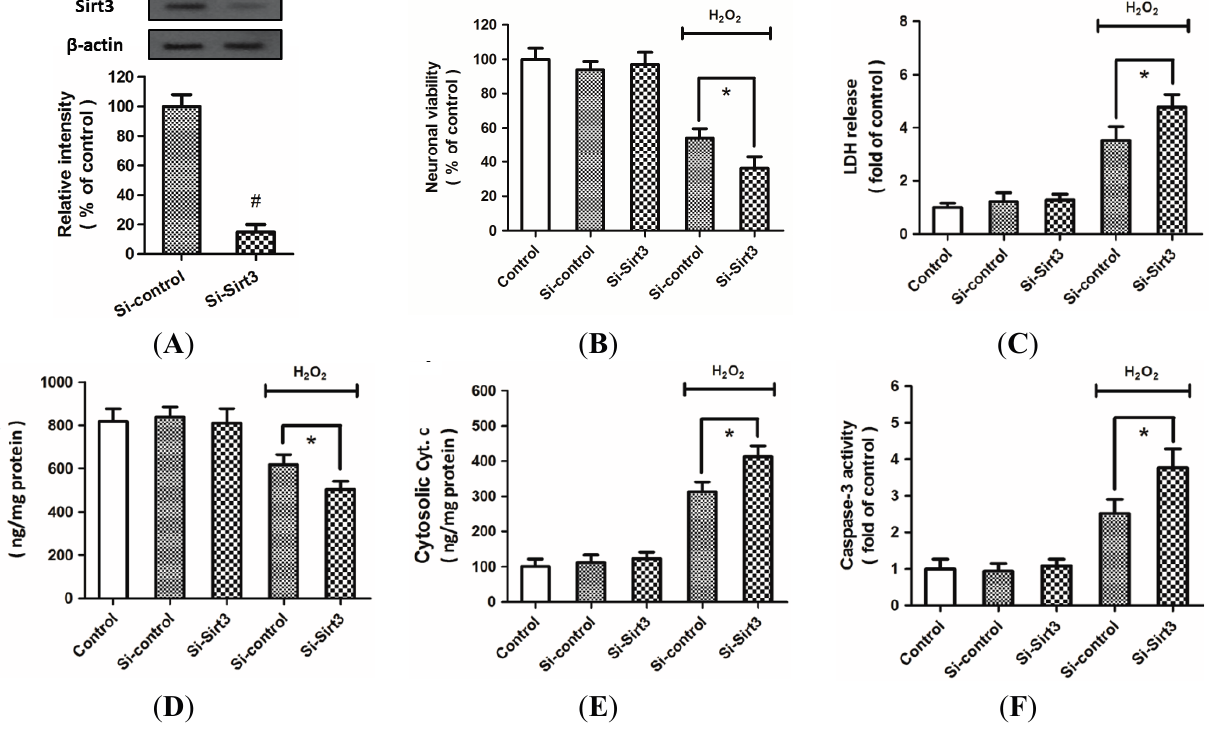
Figure 2. Knockdown of Sirt3 aggravates H O -induced neurotoxicity. Cortical neurons were 2 2 transfected with Sirt3-specific siRNA (Si-Sirt3) or control siRNA (Si-control) for 72 h. The expression of Sirt3 was measured by Western blot analysis ( A ); After transfection, neurons O for 24 h to induce oxidative stress. The neuronal viability were treated with 0.1 mM H 2 2 was measured by WST-1 assay ( B ); and cytotoxicity was measured by LDH assay ( C ); The mitochondrial cytochrome c ( D ); cytosolic cytochrome c ( E ); and caspase-3 activity ( F ) were measured. Data are shown as mean ± SD of five experiments. # p < 0.05 vs. Si-control. * p < 0.05 vs.